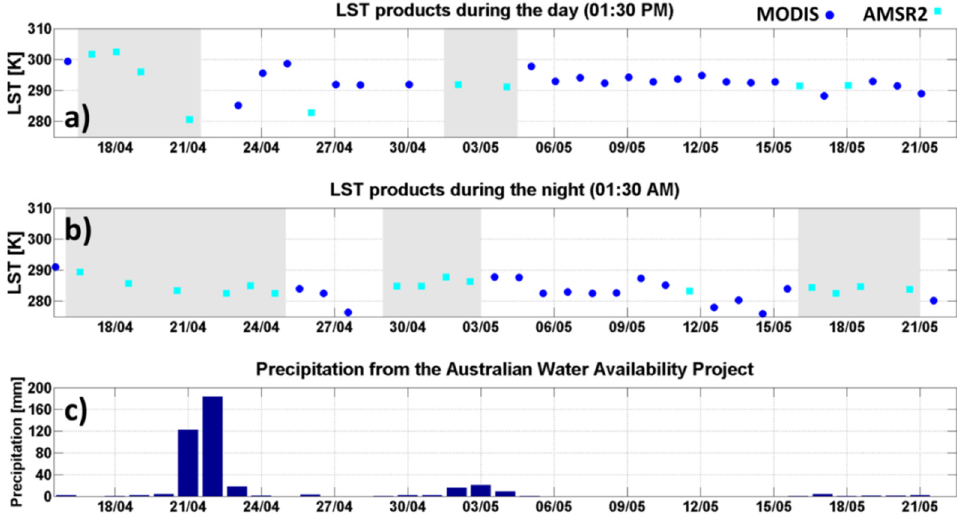
Figure 9. A recent flooding example for the Hunter Valley along Australia’s central coast demonstrating the combination approach and its usefulness for warning systems. This area experienced severe flooding after receiving significant amounts of precipitation on 21 and 22 April 2015. This timeseries demonstrates the successful scaling of AMSR2 observations resulting in an increasing number of Land Surface Temperture observations. ( a ) LST products during the day; ( b ) LST products during the night; ( c ) precipitation from the Australian Water Availability Project.